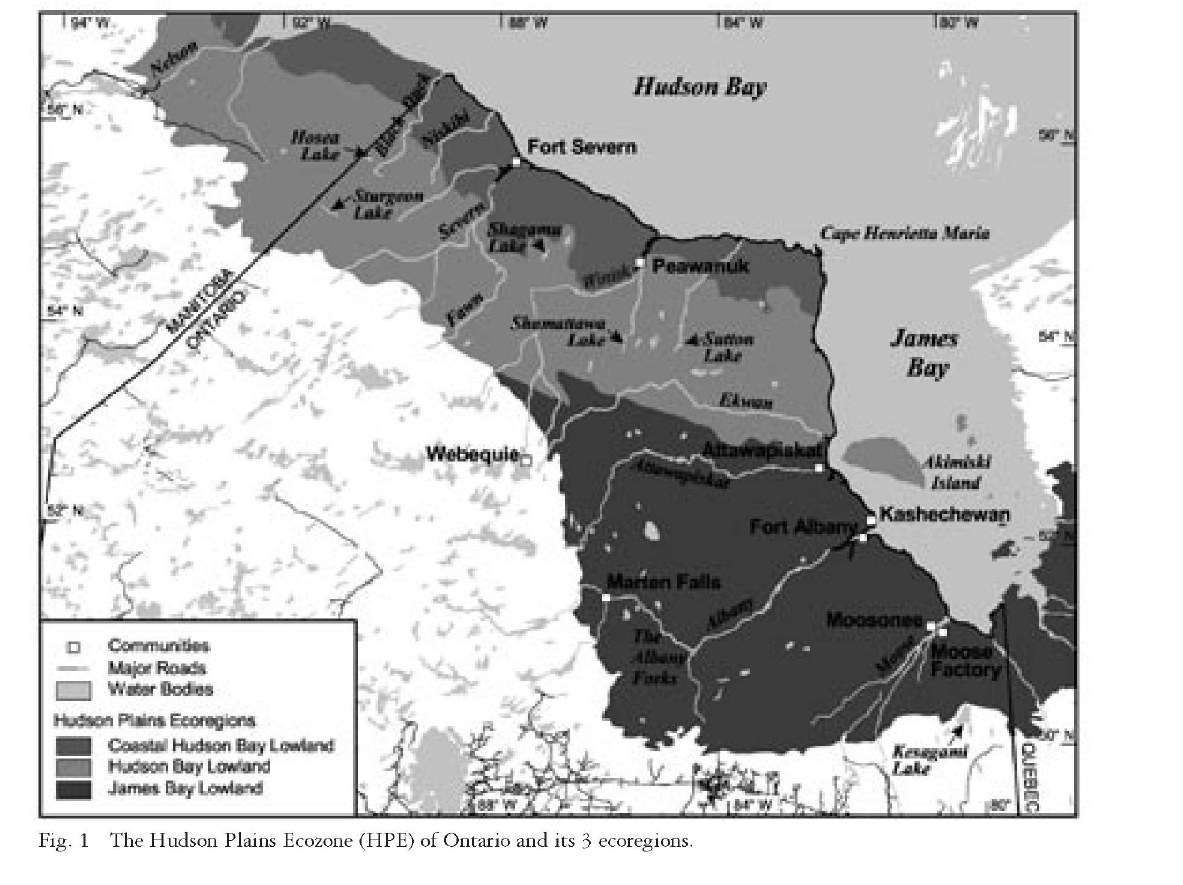
Fig. 1 The Hudson Plains Ecozone (HPE) of Ontario and its 3 ecoregions. of caribou in the southern half of the province since 1880 (Racey & Armstrong, 2000; Schaefer,